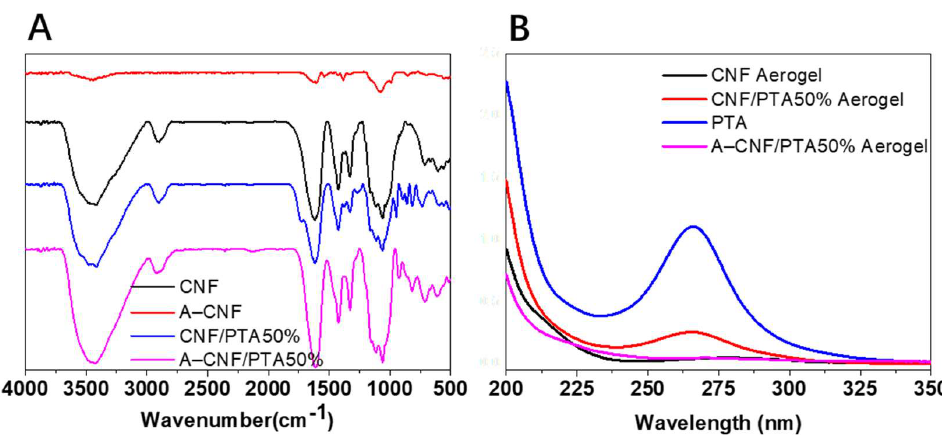
Figure 1. FT-IR spectra of the aerogels CNF, CNF/PTA50%, and A-CNF/PTA50% ( A ), and UV spectrum of the solution after immersion of aerogels ( B ).